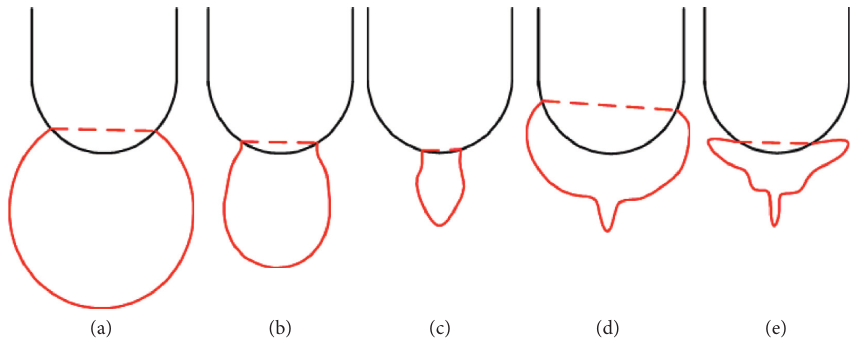
Figure 18: Diagram of oval bubble morphological characteristics. (a) First maximum volume. (b) Oval bubble. (c) Oval bubble continues to shrink. (d) Second maximum volume. (e) Second minimum